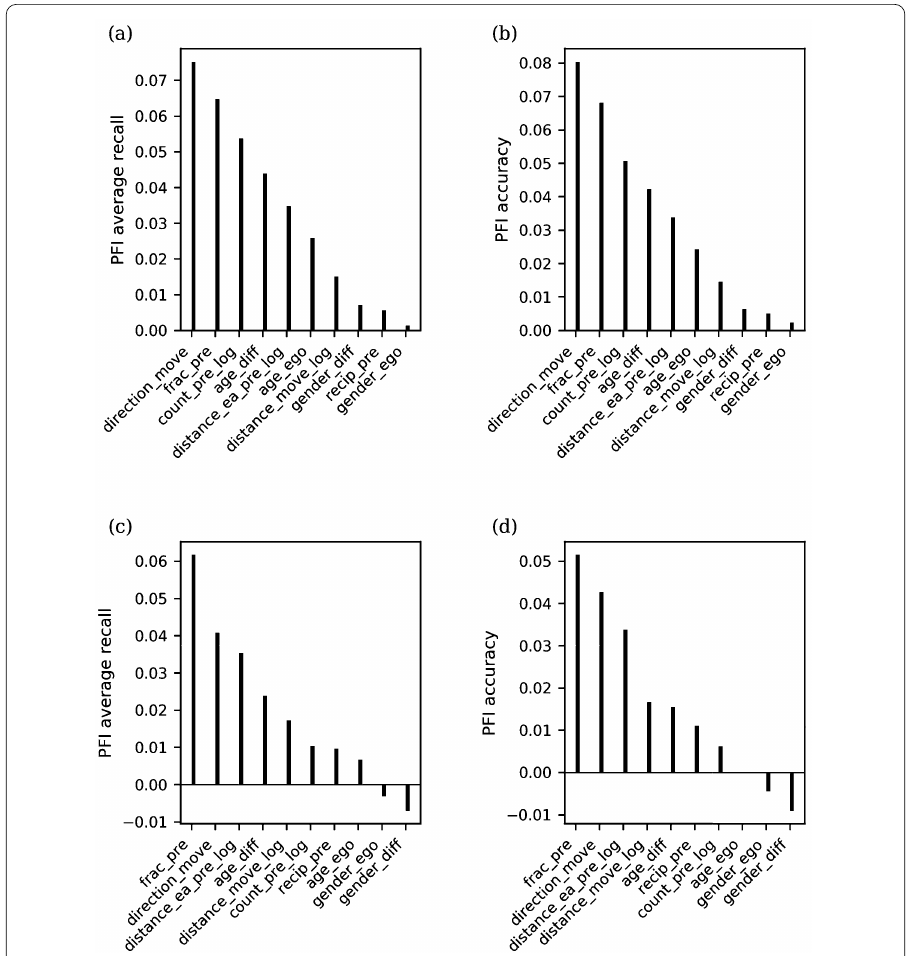
Figure 8 Permutation feature importance for rise/decay classification. These show the permutation feature importance of each predictor used in the best model for predicting rise/decay in the mean number of calls (( a ) and ( b )) and the mean fraction of calls (( c ) and ( d )). The more positive the permutation feature importance for a particular predictor is, the more shuffling the predictor values negatively affects the model